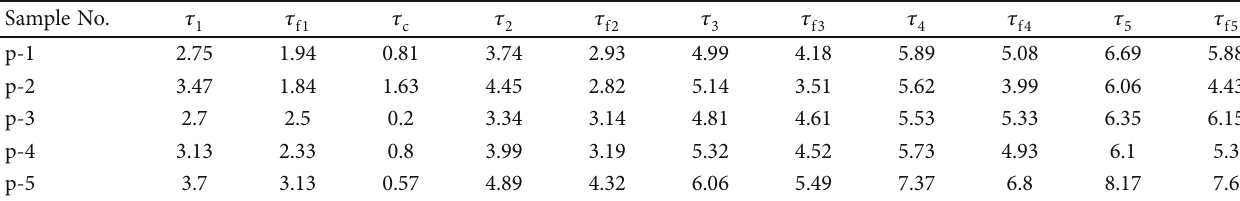
Table 2: Peak shear strength of discontinuities (unit: MPa).